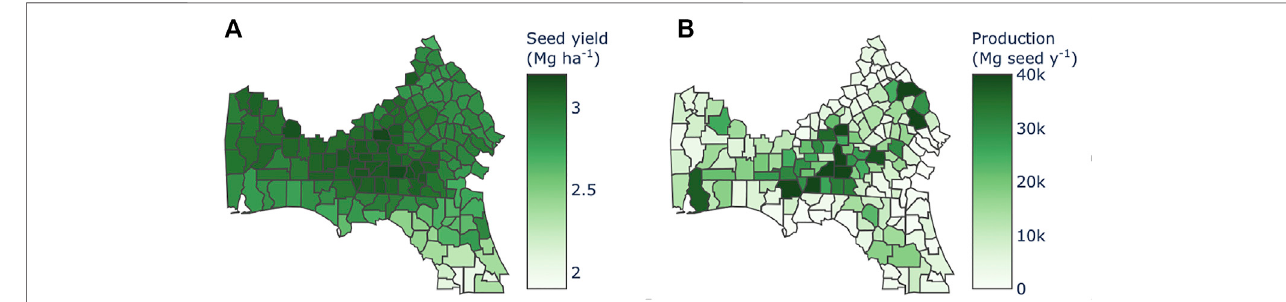
FIGURE3| DayCent-simulated (A) carinataseedyieldrates,and (B) correspondingannualseedproductionpercountywhencarinataisintegratedeverythirdyear into existing rotations across all active annual cropland, under the conventional carinata management scenario.